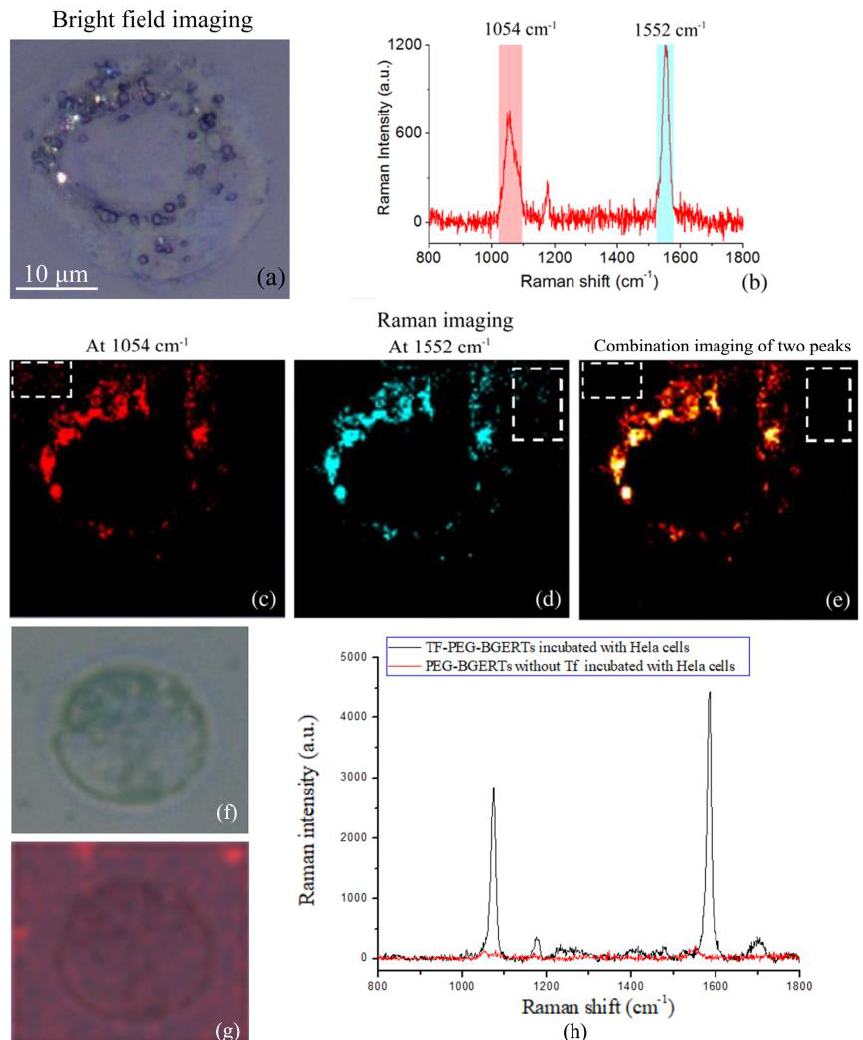
Figure 3. ( a )Bright field imaging of a single HeLa cell, ( b ) Raman spectrum of BGERTs with two characteristic peaks at 1054 and 1552 cm − 1 , BGERTs-based surface-enhanced Raman scattering (SERS) imaging of the characteristic peaks at ( c ) 1054 cm − 1 , ( d ) 1552 cm − 1 , and ( e ) 1054 and 1552 cm − 1 , in which the white squares represented that the quality of SERS imaging of two characteristic peaks was greatly improved relative to the single peak due to the spurious signals and noises being reduced, ( f ) the bright field imaging of the control sample, ( g ) SERS imaging of the control sample of the characteristic peaks at 1054 and 1552 cm − 1 , ( h ) Raman spectra of the control group and the experimental